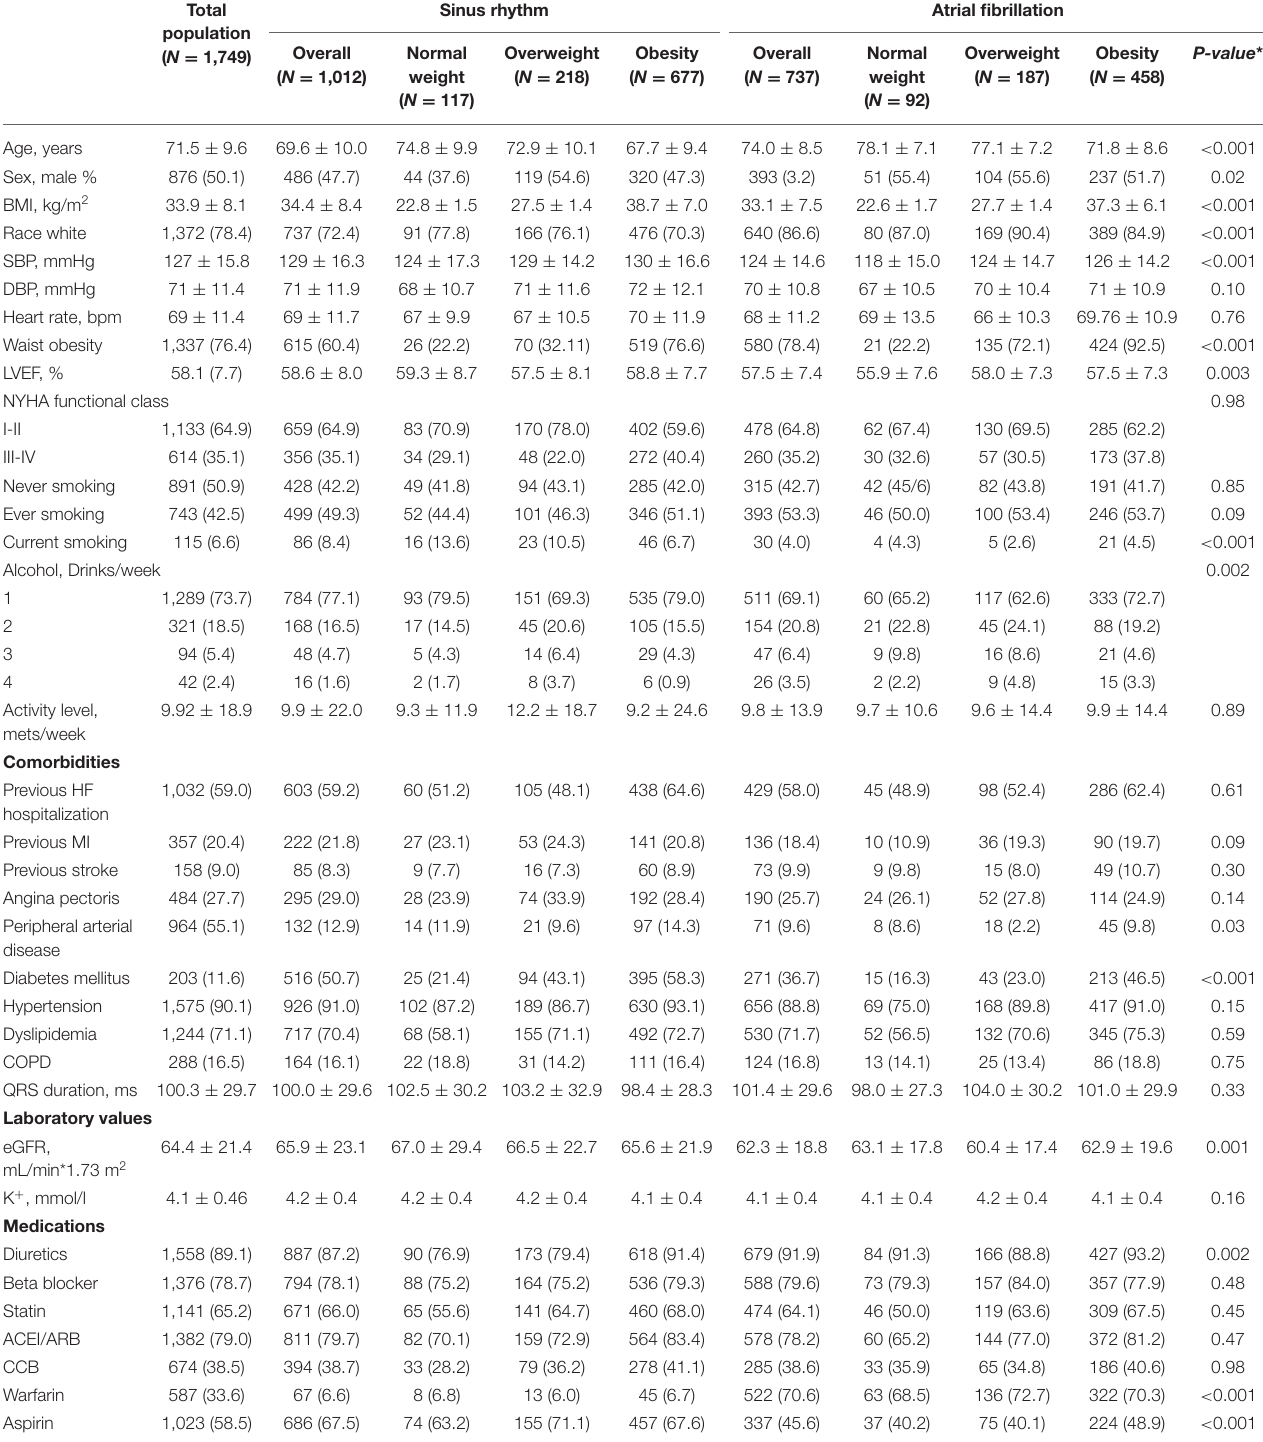
TABLE 1 | Baseline characteristics of patients with HFpEF by atrial fibrillation